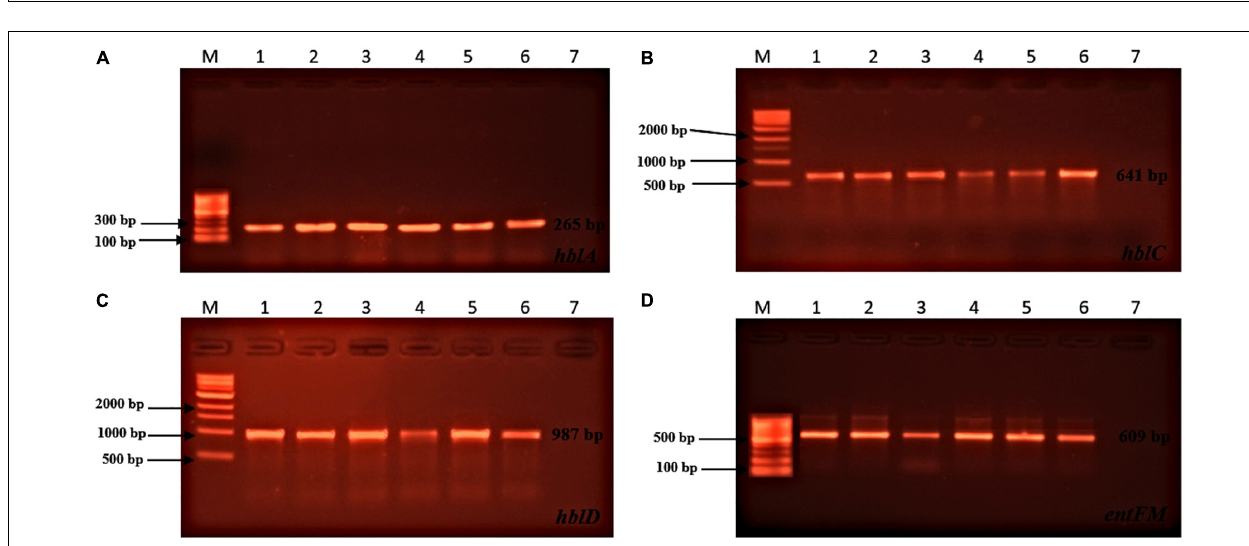
sample 4, L7: sample 5, L8: negative control); (C) ( hblD gene, L1: 1 kb marker, L2: positive control, L3: sample 1, L4: sample 2, L5: sample 3, L6: sample 4, L7: sample 5, L8: negative control); (D) ( entFM gene, L1: 100 bp marker, L2: positive control, L3: sample 1, L4: sample 2, L5: sample 3, L6: sample 4, L7: sample 5,